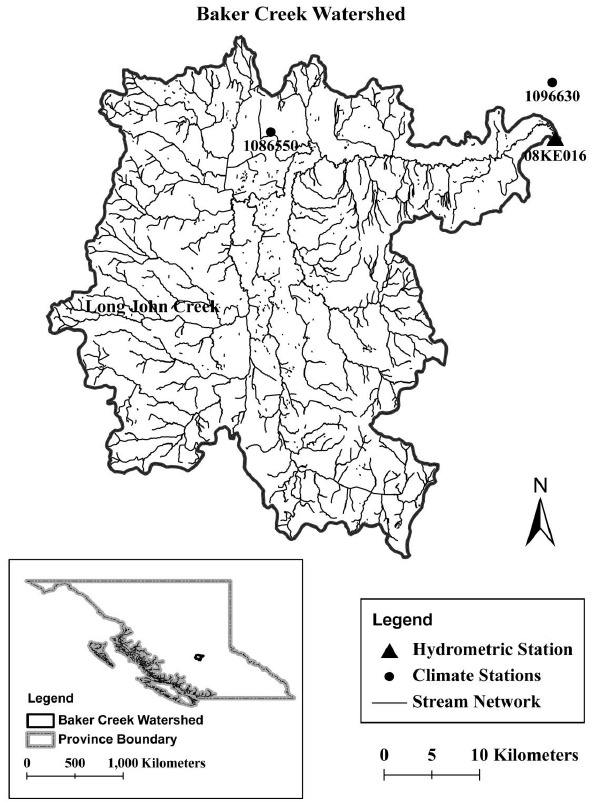
Fig. 1. Location of the study watershed in the central interior of British Columbia, Canada. Figure 1 Location of the study watershed in the central interior of British Columbia, 929